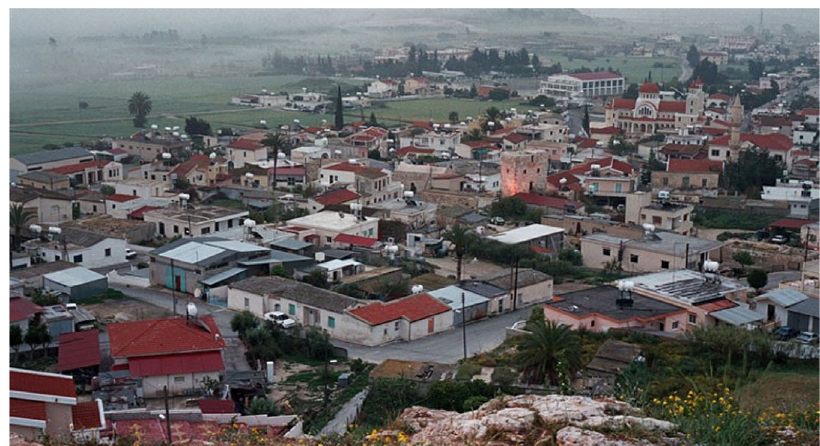
Fig. 3 Risokarpaso village. Risokarpaso general appearance.